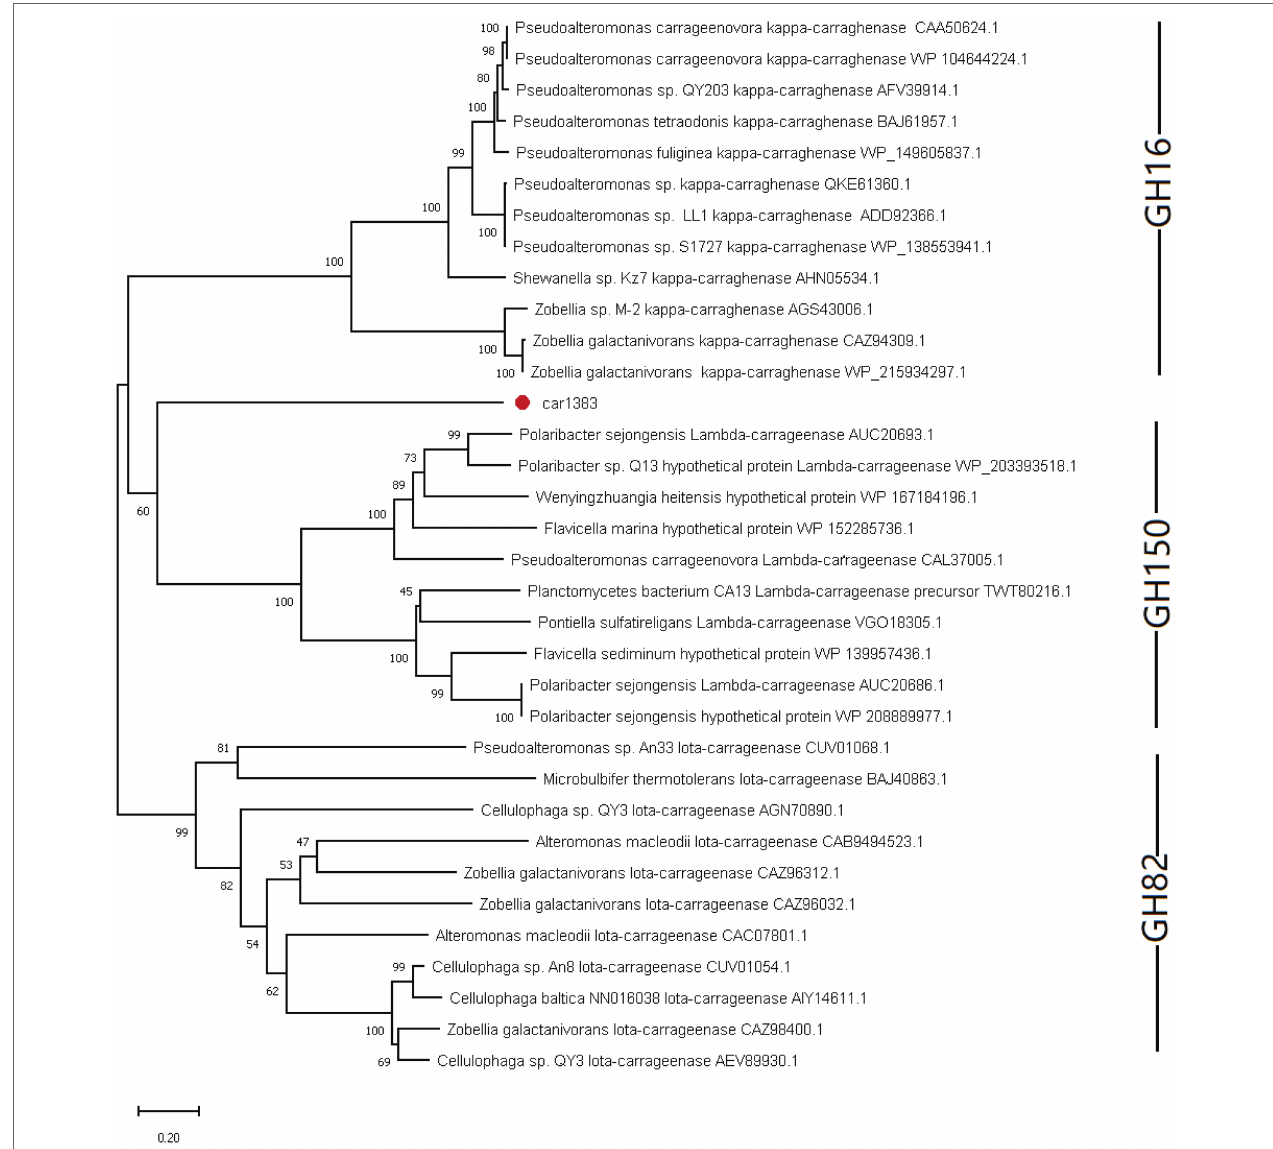
FIGURE 2 | Phylogenetic analysis of Car1383 with other carrageenases based on the amino acid sequences. The tree was constructed by the neighbor-joining method. Bootstrap values (expressed as percentages of 2,000 replications) are shown at branching